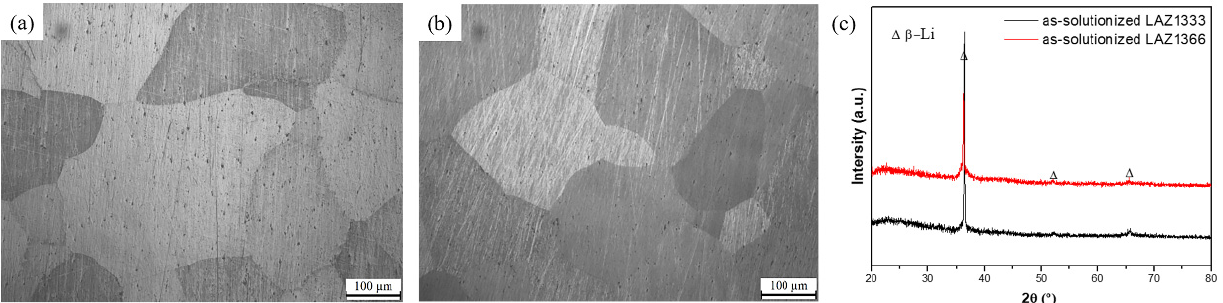
Figure 6. The microstructure of as-solutionized LAZ13 xy ( x = 3, 6 wt%, y = 3, 6 wt%) alloys: OM images of ( a ) LAZ1333 and ( b ) LAZ1366, ( c ) XRD pattern.